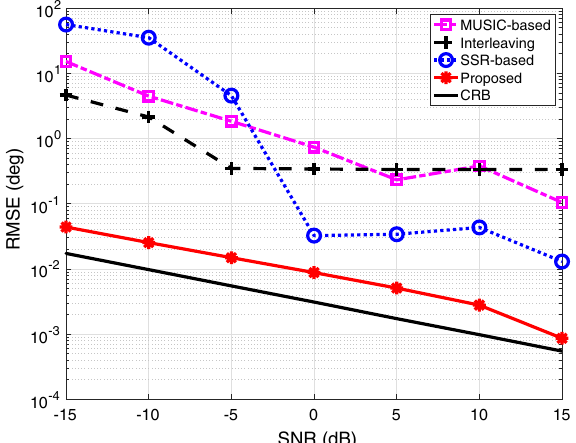
Fig. 6 DOA estimation accuracy comparison with differnet SNR of